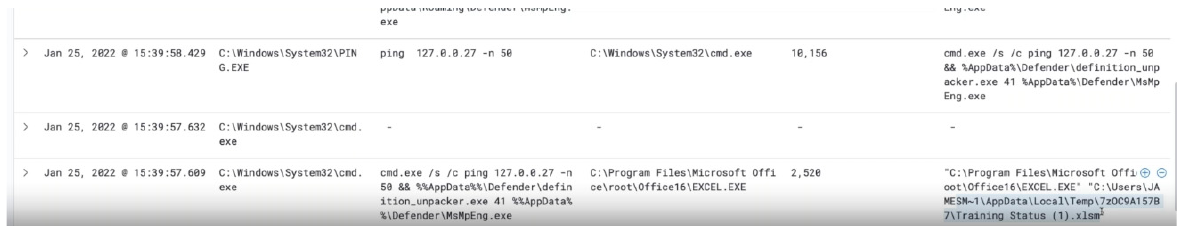
Figure 14. Process ID filtering results.